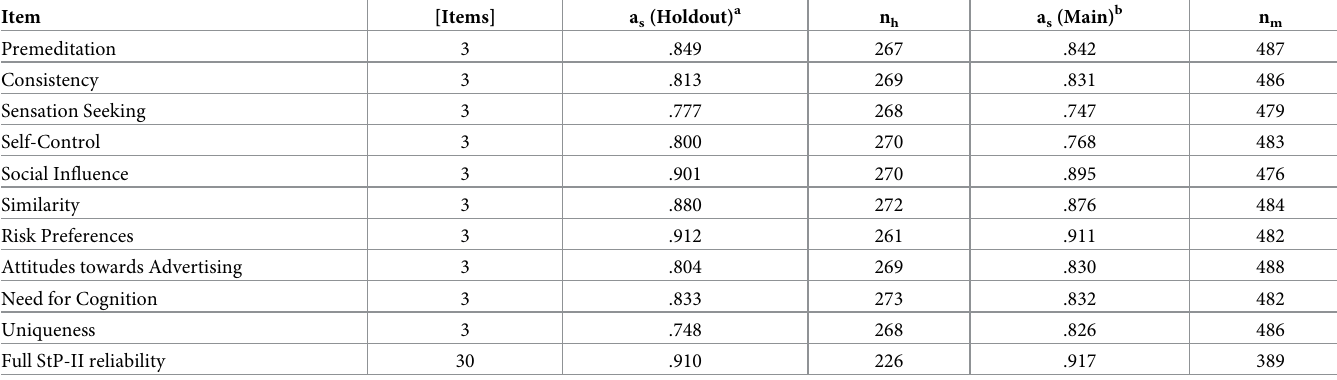
Out of the two most commonly used factoring techniques Principal Axis Factoring was employed. The Maximum Likelihood method assumes multivariate normal distribution of the variable (e.g. [69]) and that condition was not fulfilled in our data, most notably in DOS- PERT-R where respondents self-reported to be highly risk averse, thus skewing the distribu- tion. Direct Oblimin rotation was used, as we assumed that certain factors would share variance. Initial eigenvalues showed that the first factor explained 27% of the variance, the sec- ond 9%, the third factor 8% of the variance, the fourth, fifth and sixth factor 3% of the variance, the seventh, eighth and ninth factor approximately 2% of the variance and the tenth factor 1% of the variance. The ten-factor solution (of subscales with eigenvalues > 1) explained 59% of the variance. Factor loadings ranged from .452 to .819 with minimal cross-loading. All factor loadings for full StP-II scale are listed in S1 Table in the Supplemental Materials Section.